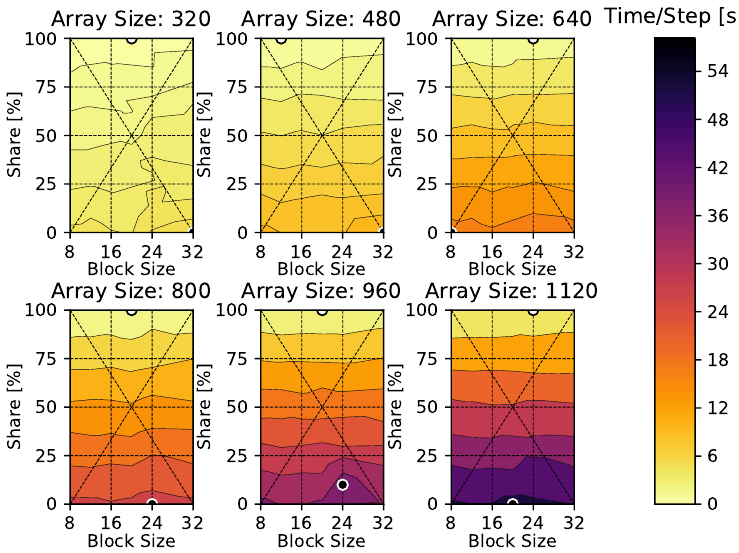
Figure A7. Euler equations time per timestep performance using Swept to solve the Euler equations with Intel Skylake Silver 4114 CPUs and GeForce GTX 1080 Ti GPUs.